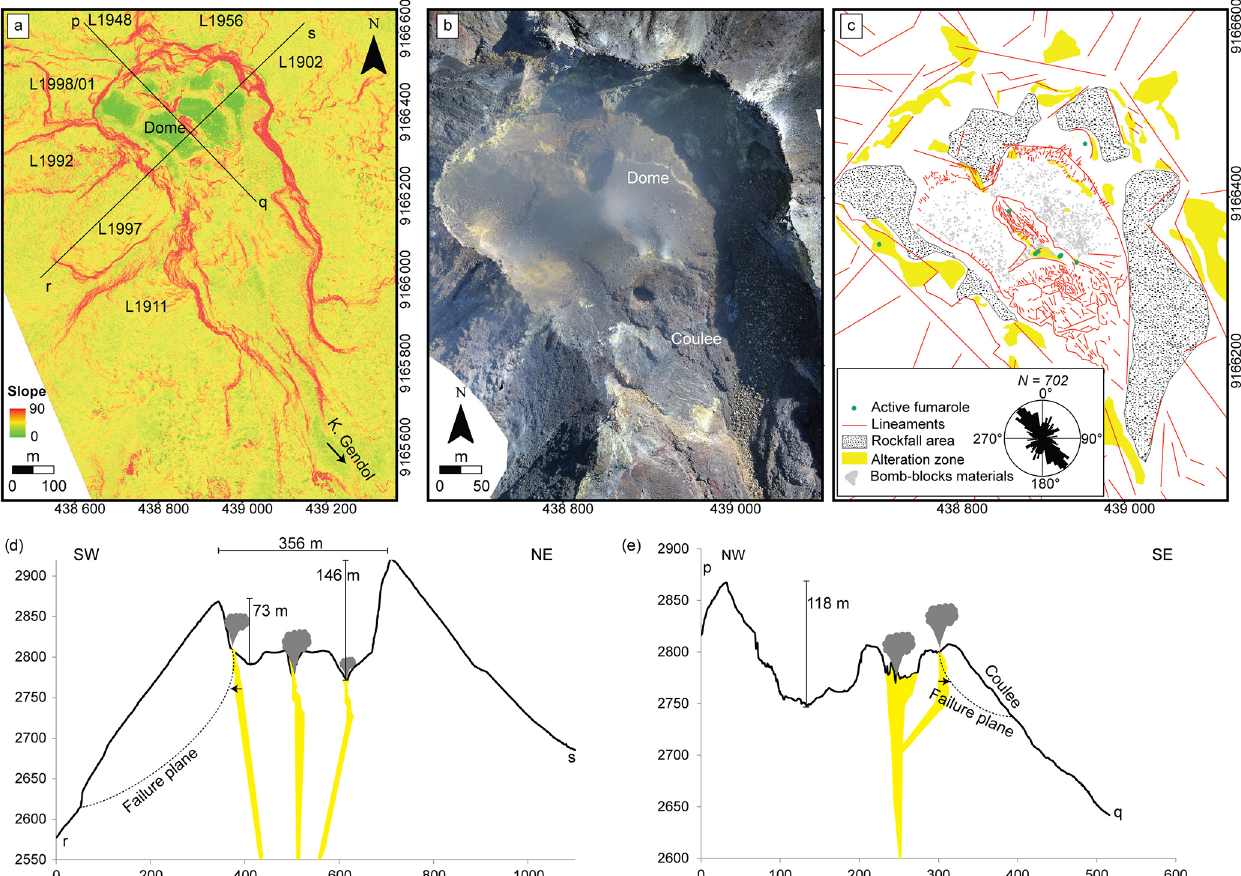
Figure 2. (a) Slope map of the Merapi summit shows that the Merapi flanks are steep, especially the crater which has a slope of ∼ 80 ◦ . (b) Photomosaic of drone aerial images shows that the summit is highly fractured with 150 ◦ from N to E and highly altered. (c) Rock alteration occurs at the crater wall, the fissure at the dome, and the southern sector of the dome. A cross section of lines (d) r-s and (e) p-q show that the crater has a maximum depth of 146m at the northeast area. The current Merapi dome is located in the middle of the deep crater and shows a possible unstable sector as sketched in (e)